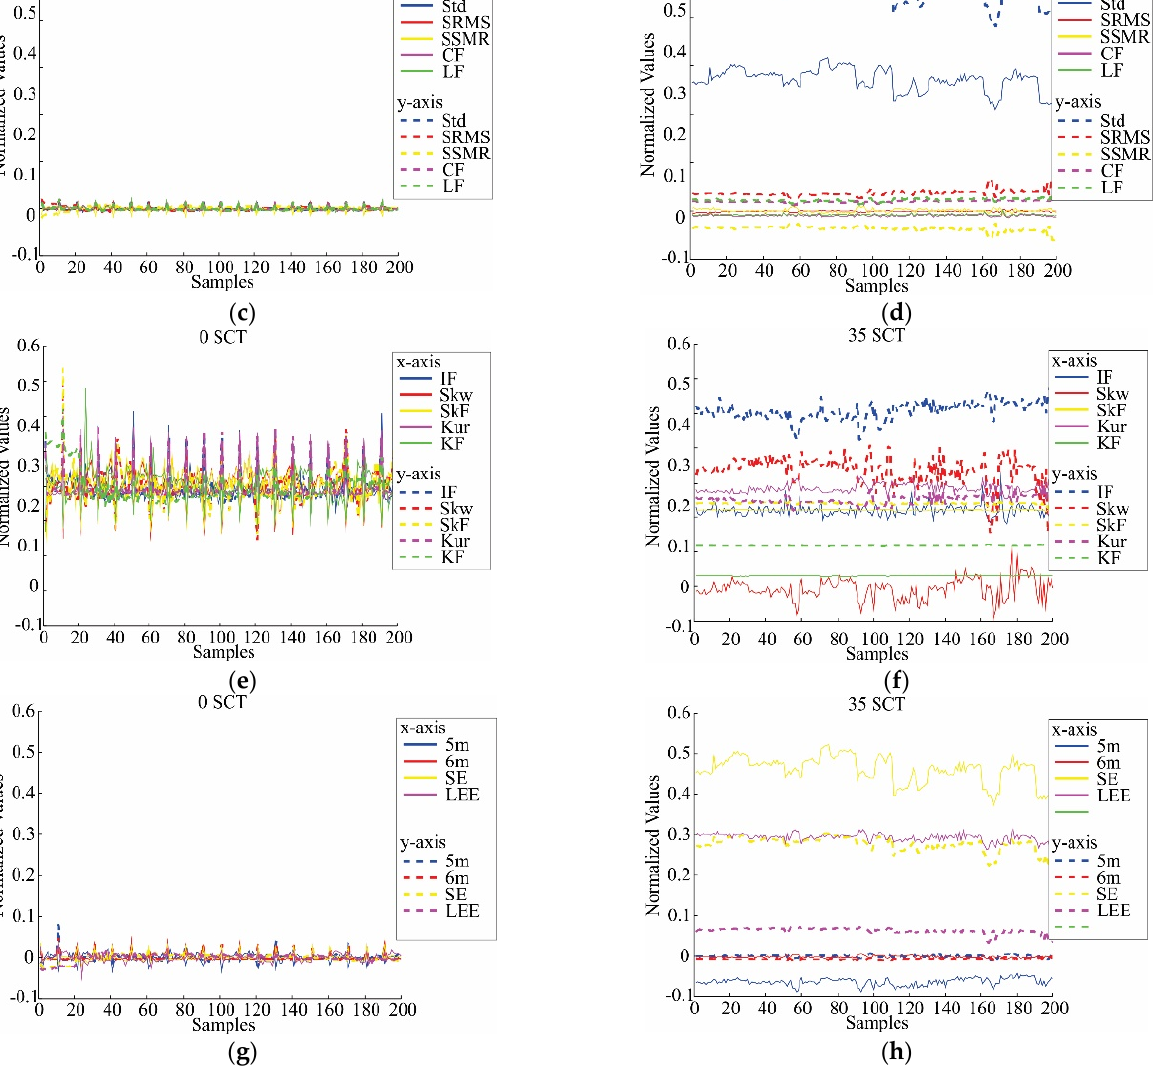
Figure 8. Estimated normalized features in healthy condition and 35 SCTs fault condition: ( a ) Mean, maximum value (Max), RMS, SRM, and variance (Var) for 0 SCT; ( b ) Mean, maximum value (Max), RMS, SRM, and variance (Var) for 35 SCT; ( c ) Standard deviation (Std), shape factor (RMS) (SRMS), shape factor (SRM) (SSRM), crest factor (CF), and latitude factor (LF) for 0 SCT; ( d ) Standard deviation (Std), shape factor (RMS) (SRMS), shape factor (SRM) (SSRM), crest factor (CF), and latitude factor (LF) for 35 SCT; ( e ) Impulse factor (IF), skewness (Skw), skewness factor (SkF), kurtosis (Kur), and kurtosis factor (KF) for 0 SCT; ( f ) Impulse factor (IF), skewness (Skw), skewness factor (SkF), kurtosis (Kur), and kurtosis factor (KF) for 35 SCT; ( g ) 5th Normalized moment (5m), 6th normalized moment (6m), Shannon entropy (SE), and log energy entropy (LEE) for 0 SCT; ( h ) 5th Normalized moment (5m), 6th normalized moment (6m), Shannon entropy (SE), and log energy entropy (LEE) for 35 SCT.